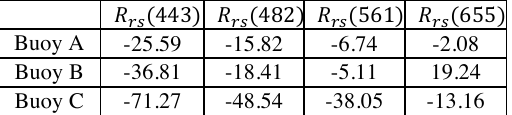
Table 1. The matchup analysis for the OLI-derived products shown in %.